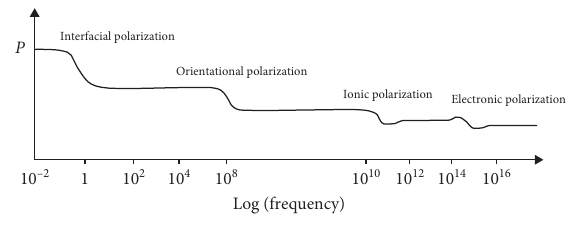
Figure 2: Frequency dependence of different dielectric